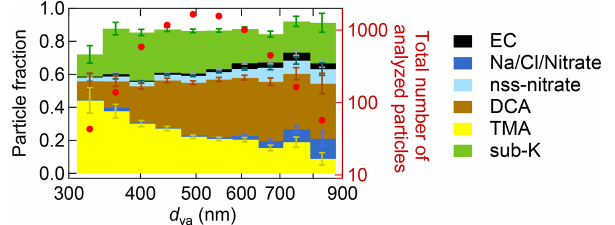
Figure 12. Size-resolved aerosol composition of the ALABAMA particle types during the Arctic air mass period. The figure rep- resents the cumulative particle fraction of EC-containing (black), nss-nitrate-containing (light blue), DCA-containing (brown), Na/Cl/Nitrate-containing (dark blue), TMA-containing (yellow), and sub-K-containing (green) particles, as well as the total num- ber of analyzed particles per bin (red). Uncertainty analysis is given in Sect.